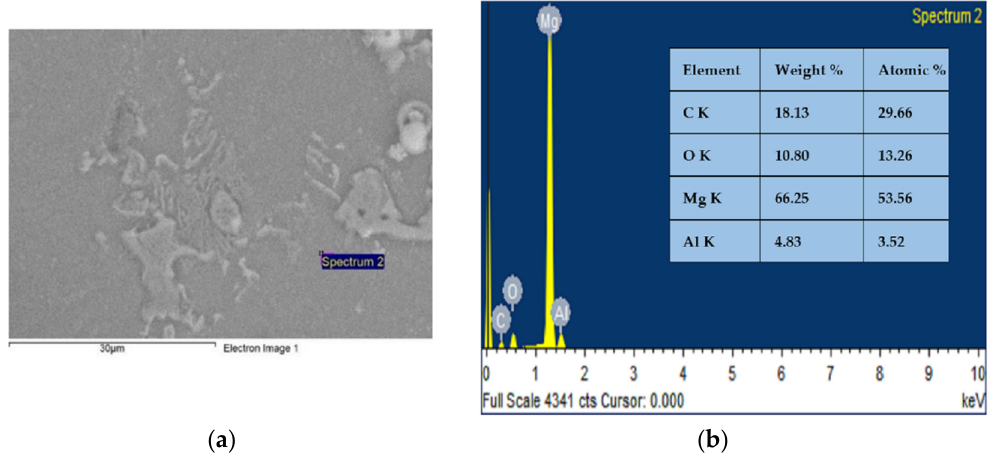
Figure 11. EDS analysis (a) depicts the presence of carbon (from CFs and CNTs) and oxygen, and (b) depicts other metals, such as Mg and Al.